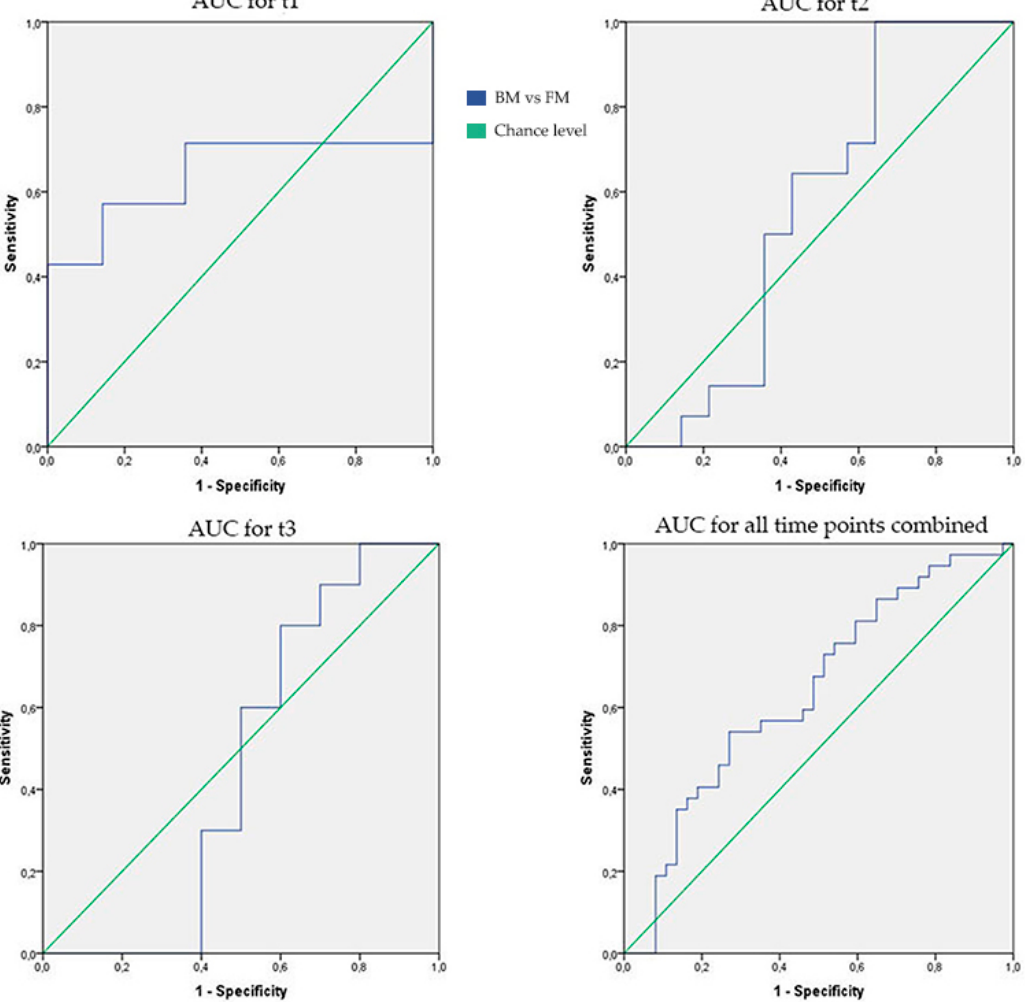
Figure 2. Area under curve (AUC) for all individual time-points and all time-points combined.